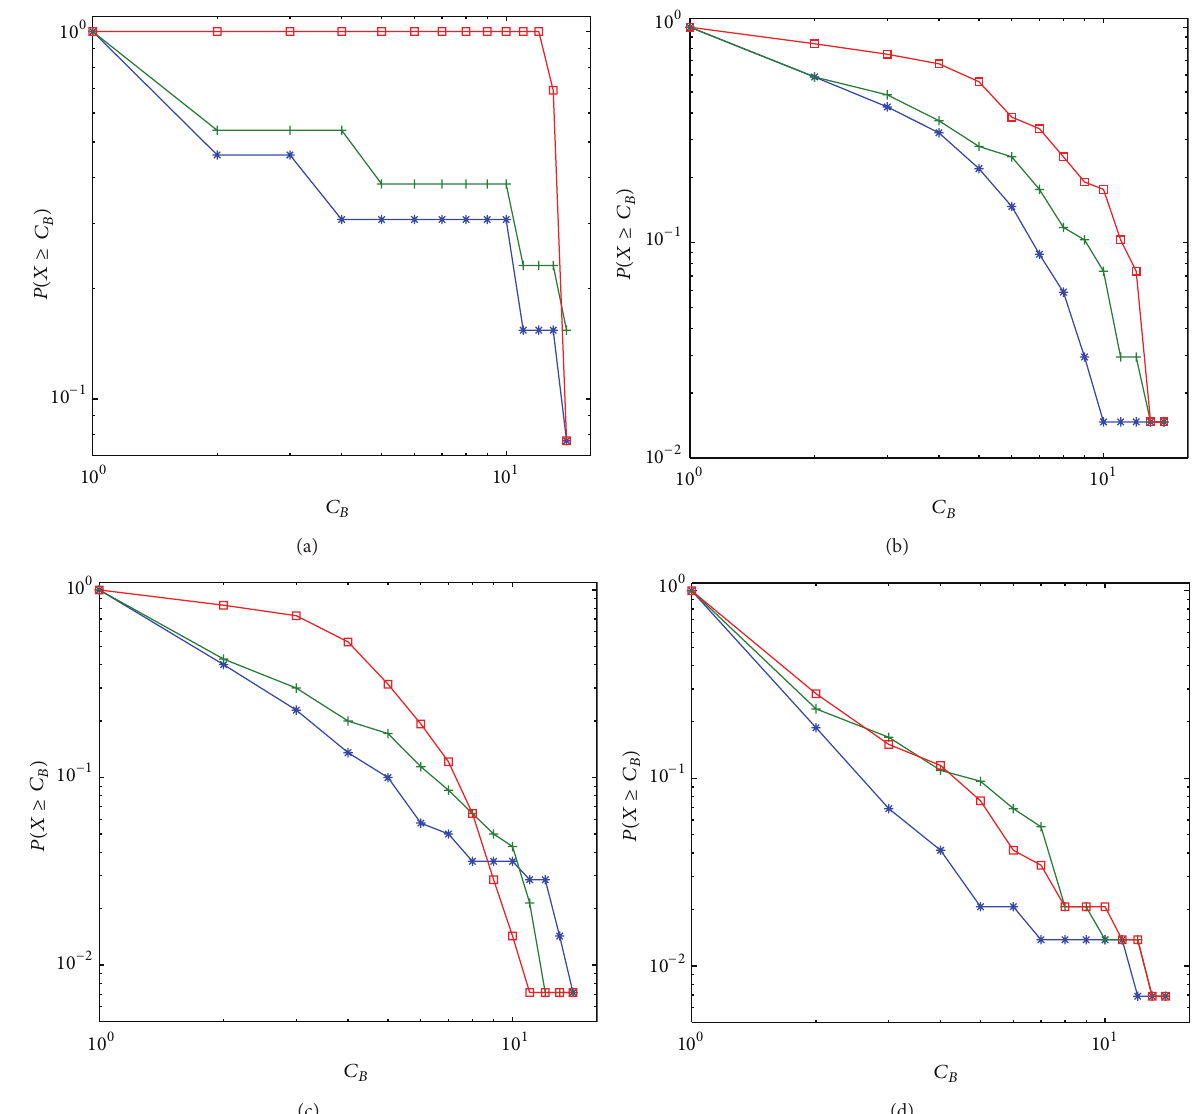
Figure 9: CDF of the betweenness index of (a) G 4 , (b) G 16 , (c) G 48 , and (d) G 50 obtained using three different definitions: the original definition —+—, the proposed modification — ∗ —, and the centrality based on |𝑧 𝑖𝑖 | — ◻